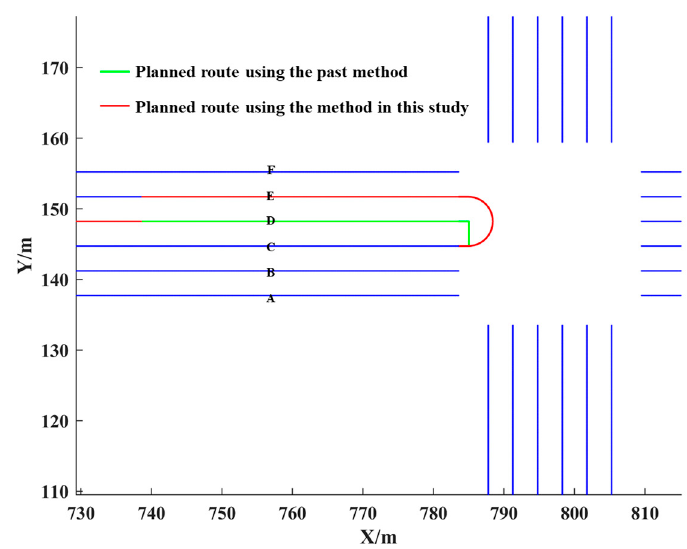
Figure 12. The constructed road network includes four roads and an intersection. Each road has six lanes, each with a width of 3.5 m. The lanes on the left road are represented by A–F. The average speed on all six lanes is set to be the same. Lane A, B, and C enter the intersection, and Lane D, E, and F exit. The traffic rules on Lane C allow for left turns and U-turns. The lane-level route from Lane C to Lane D is demonstrated. The green route is obtained using the method in Ref. [3].